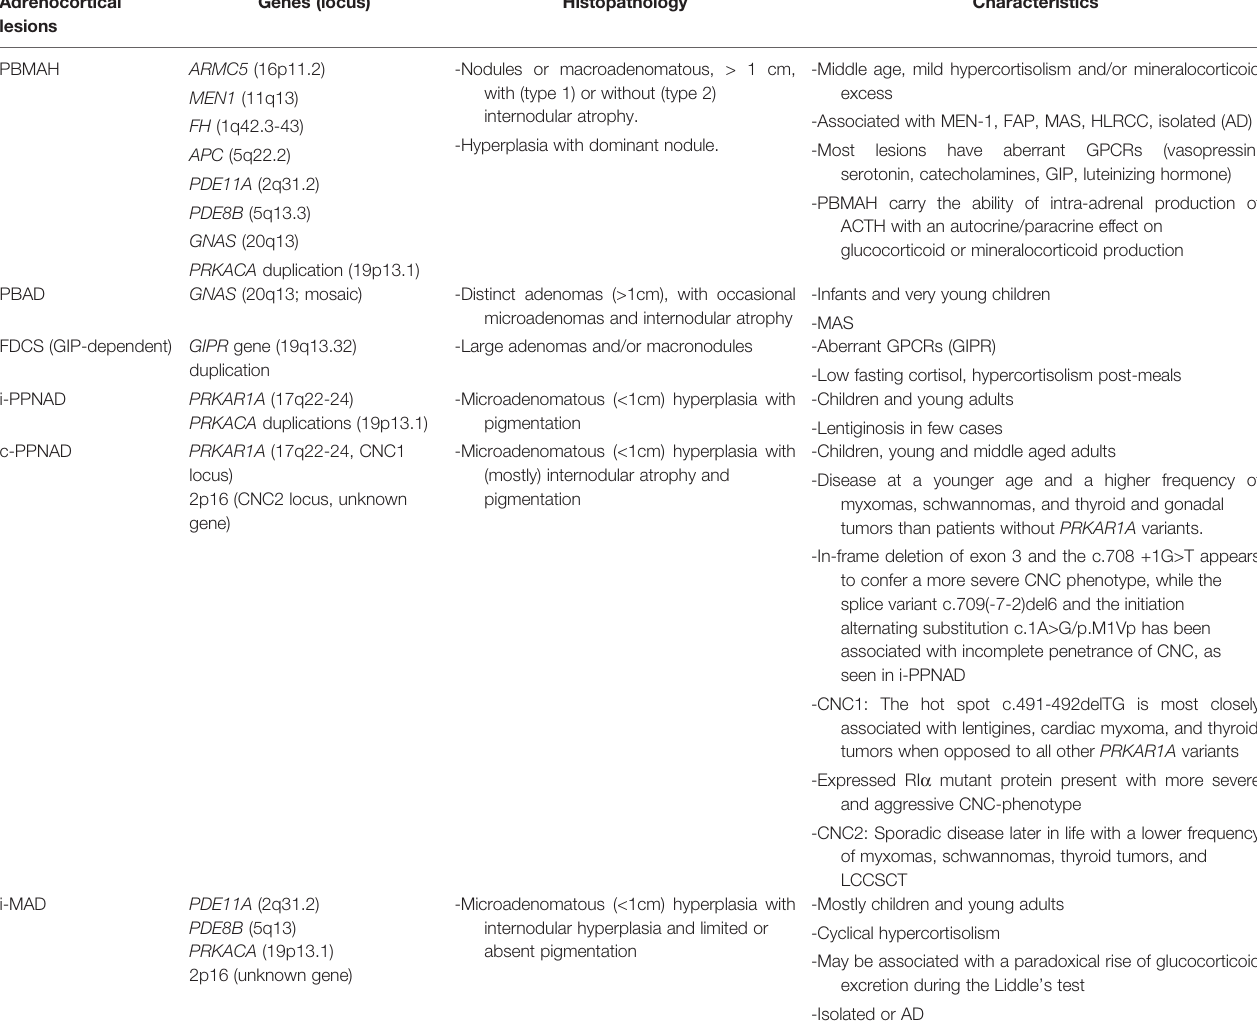
TABLE 1 | Classi fi cation and characteristics of primary cortisol-producing adrenocortical hyperplasia.* Adrenocortical Genes (locus) Histopathology lesions